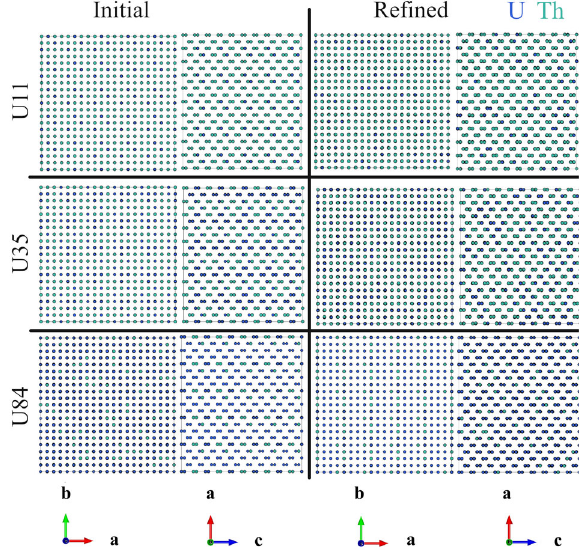
Fig. 4 Atomic models of U and Th in uranothorites obtained from RMC modeling. The blue and cyan circles represent U and Th atoms, respectively. Atomistic models are compared to the initial con fi g- urations along both the c -axis (left column of each pair) and b -axis (right column of each